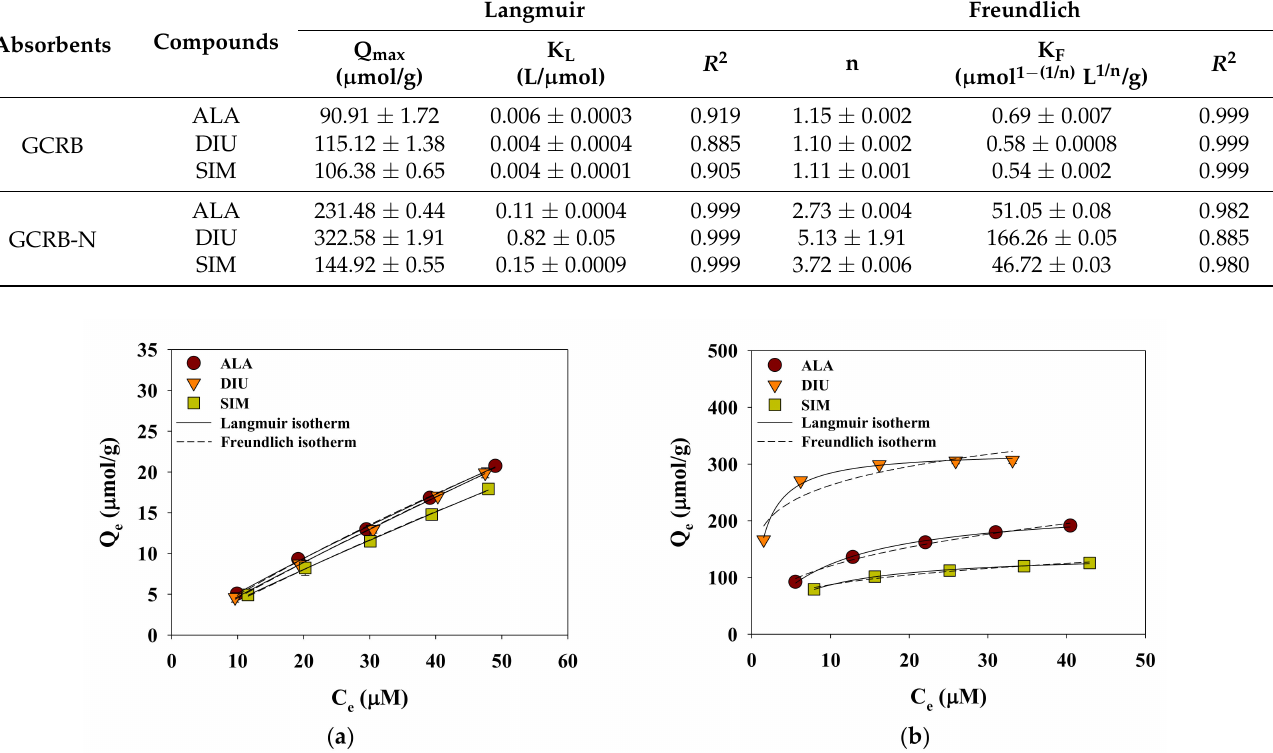
Figure 6. The adsorption isotherms of the herbicides on ( a ) the GCRB and ( b ) GCRB-N (agitation speed = 150 rpm, contact period = 24 h, absorbent dosage = 50 mg/L, initial concentration = 10–50 µ M, pH = 7.0, and temperature = 25